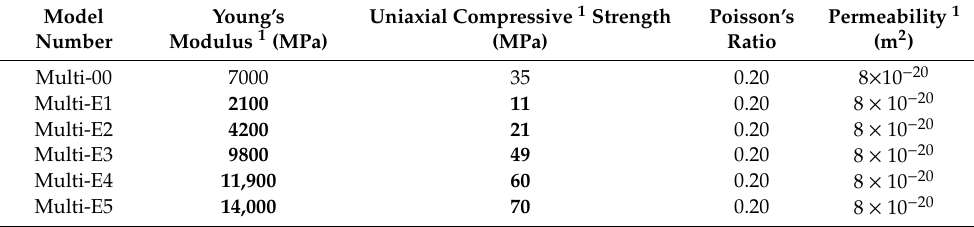
Table 3. The material parameters of the interlayer in multilayered laboratory-scale